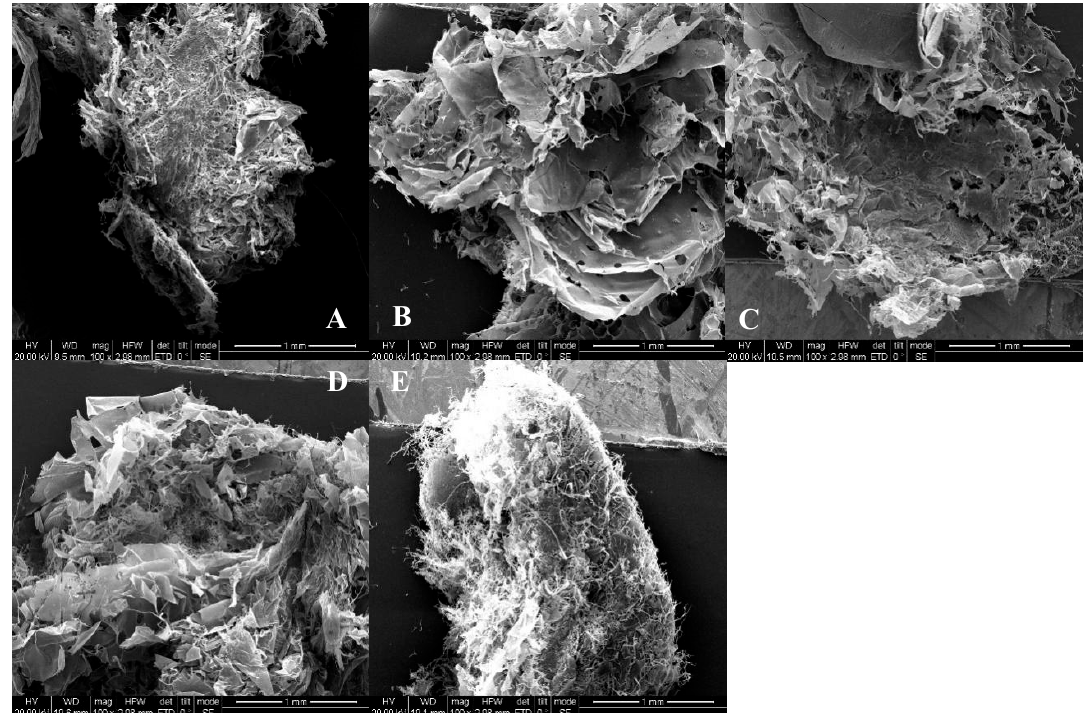
Figure 4. Surface morphological images of WEAX before and after the degradation by endo-1,4- β - xylanase. Note: the five pictures A , B , C , D , E represent the surface morphological images of WEAX after degradation for 0, 3.5, 7, 12, and 24 h, respectively.